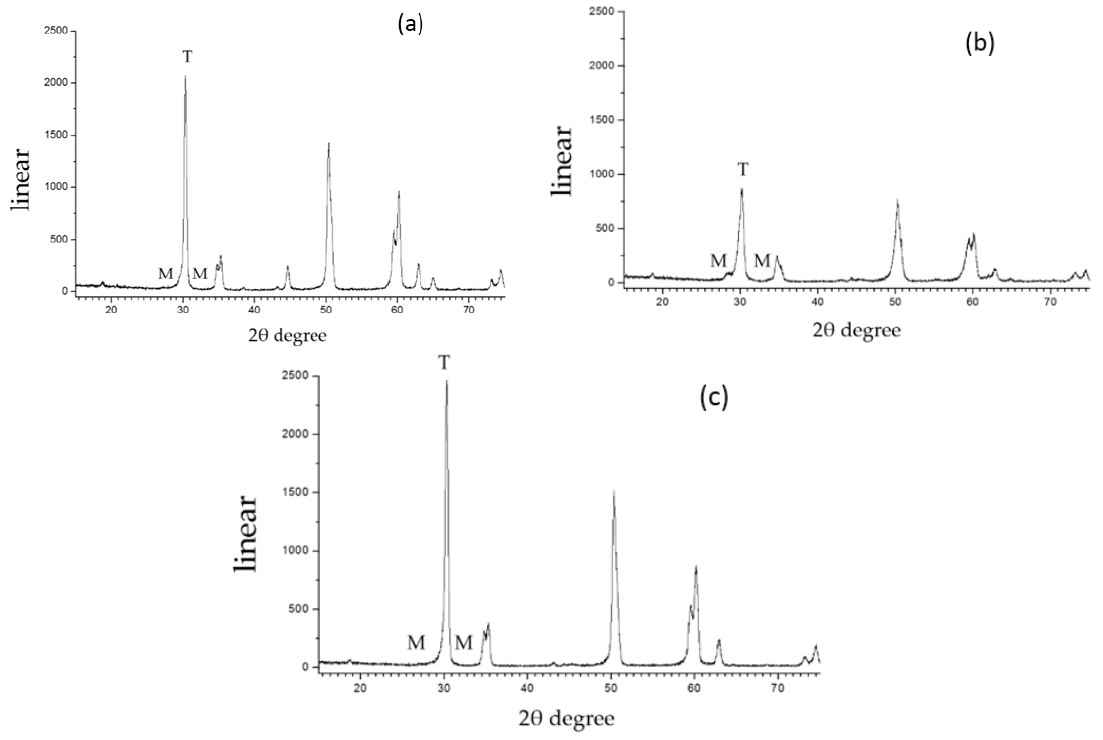
Figure 4. X ‐ ray diffraction (XRD) analyses of each group: ( a ) blank control; ( b ) airborne ‐ particle ‐ abrasion; Figure 4. X-ray diffraction (XRD) analyses of each group: ( a ) blank control; and ( c ) hot ‐ etching. T indicates the tetragonal zirconia phase and M indicates the monoclinic ( b ) airborne-particle-abrasion; and ( c ) hot-etching. T indicates the tetragonal zirconia phase zirconia phase. and M indicates the monoclinic zirconia